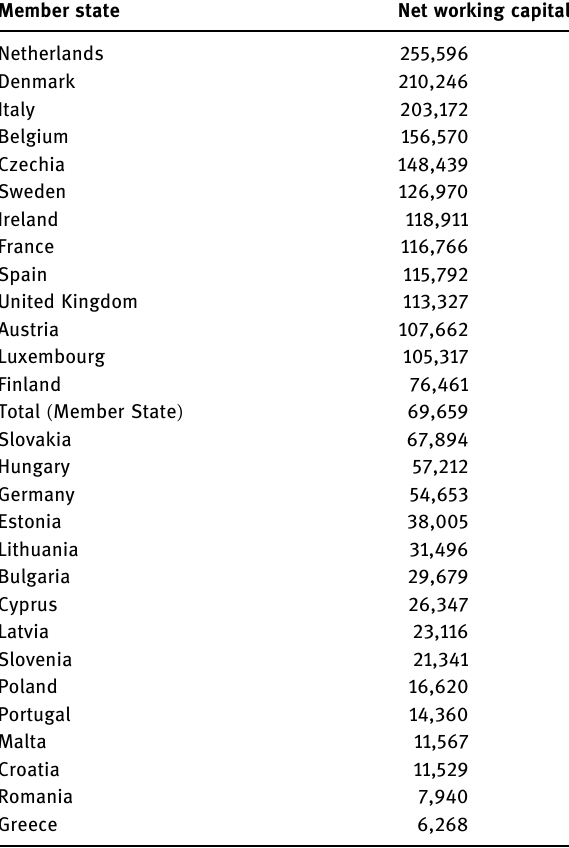
Table 3, with data for the representative farms con - sidering together countries and farming types, con fi rms